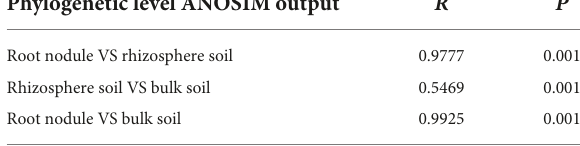
TABLE 3 Analysis of similarity. Phylogenetic level ANOSIM output